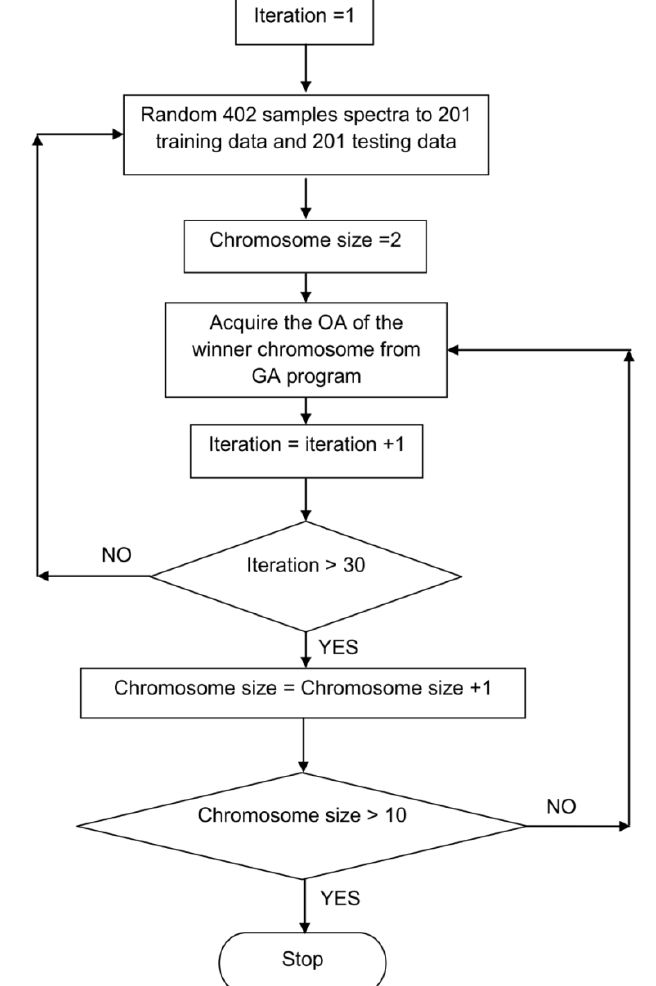
Figure 3. A flowchart (after [60]) showing the concept of the band selection and classification algorithm (OA = Overall Accuracy; GA = Genetic